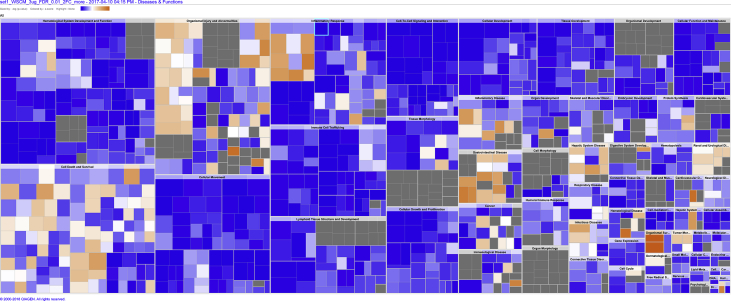
Square map showing the enriched disease and biological functions by high WS-CM. The square map was colored based on the z-score, which is a statistical measure of the match between expected relationship direction and observed gene expression. The color scale represents the activation z-score ranging from −3.244 (dark blue) to 4.902 (dark orange). Gray represents a z-score of 0. A z-score > 2 or < −2 is considered significant. The actual z-score is weighted by the underlying findings, the relationship bias, and dataset bias.